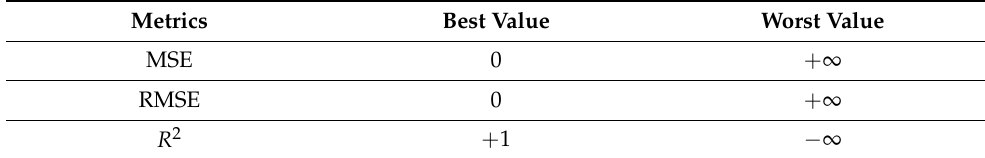
Table 5. The best values and worst values of MSE, RMSE, and R 2 .